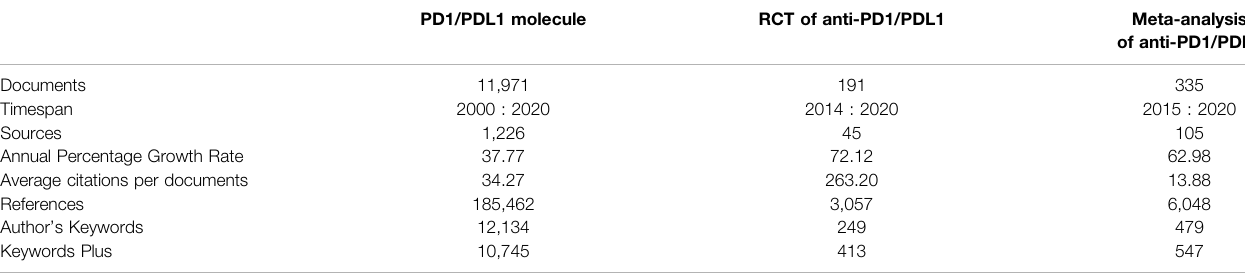
TABLE 1 | Summary of the main information of collected bibliometric data about three